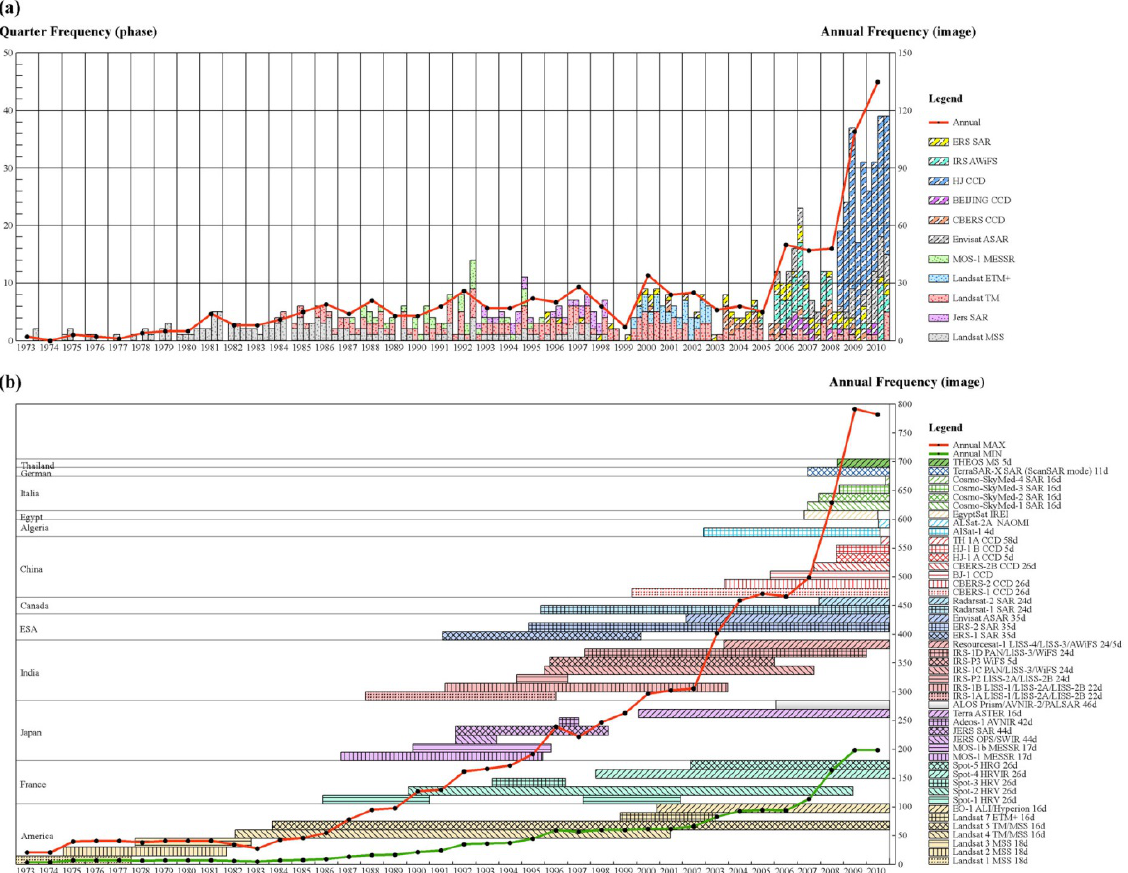
Figure 7. Quarterly frequency of high-quality satellite images over the study area from 1973 to 2010. Please add subfigures caption in the caption. ( a ) Quarterly availability of high-quality satellite images based on the preview images taken by common satellite sensors; ( b ) Estimated quarterly availability of high-quality satellite images taken by all satellite sensors from 1973 to